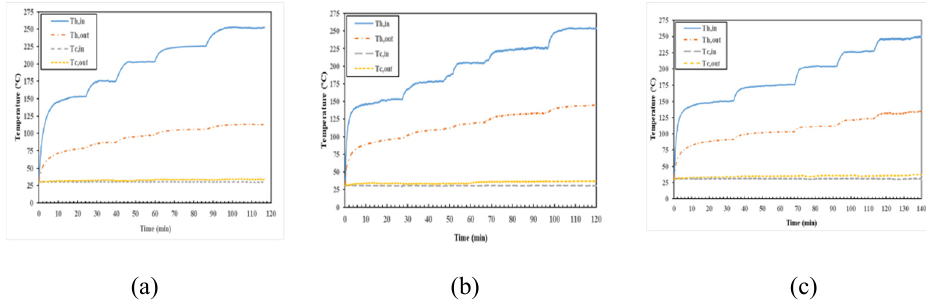
Figure 6. The temperature change over time with a continuous increase in the inlet air temperature with inlet air inlet air velocities of ( a ) 0.3 m/s ( b ) 0.5 m/s and ( c ) 0.7 m/s.